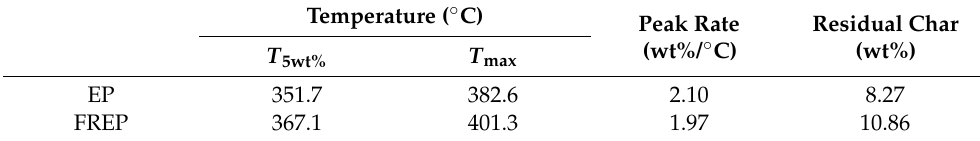
Figure 4. Thermal stability for EP composites.